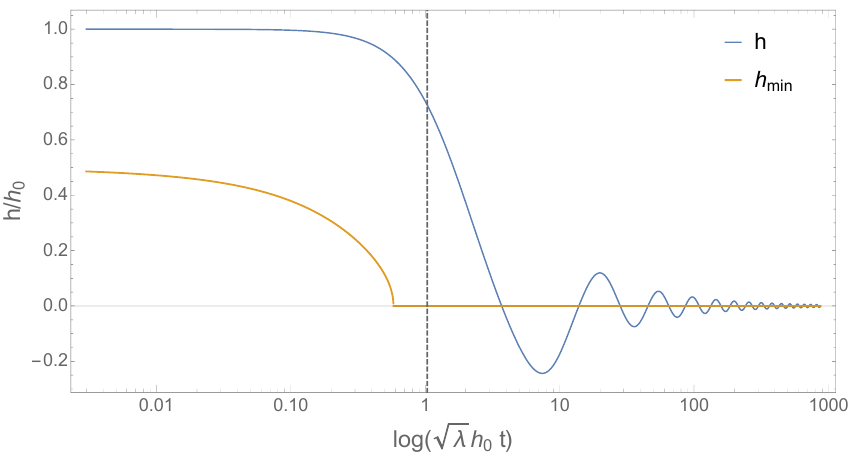
Figure 2 . Higgs relaxation from free-fall initial conditions. The parameters are (cid:3) I = 10 16 GeV, (cid:0) I = 10 6 GeV, and (cid:21) = 0 : 001. The blue line shows the evolution of the Higgs VEV during reheating. The yellow line shows the positive minimum of the Higgs potential. The dashed line indicates the time when maximum temperature is